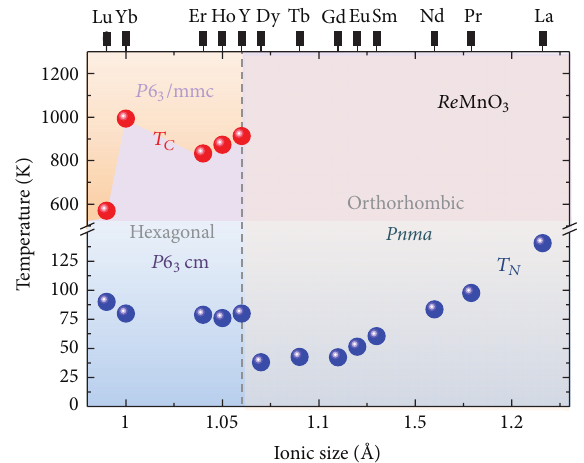
Figure 1: Lattice structure in ReMnO 3 as a function of the size of the rare-earth elements [11, 24–29].